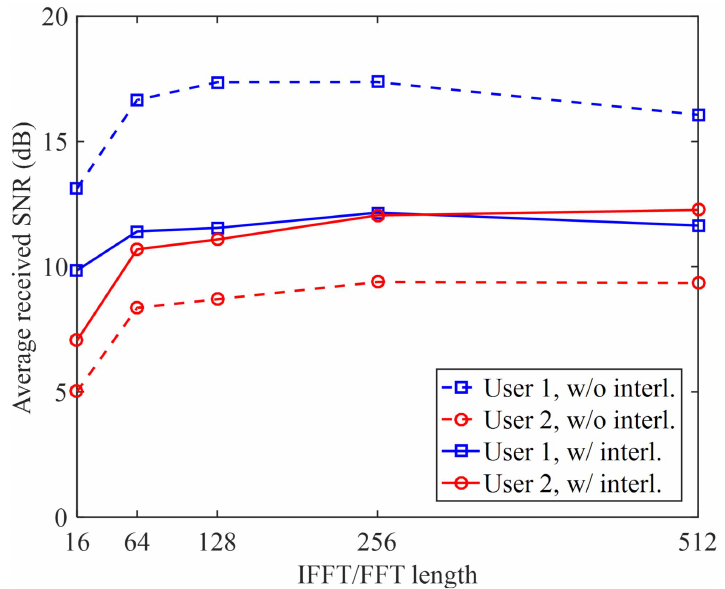
Figure 7. Average received SNR vs. IFFT/FFT length of the DFT-S-OFDM signal (w/o: without, w/: with, interl.: interleaving).